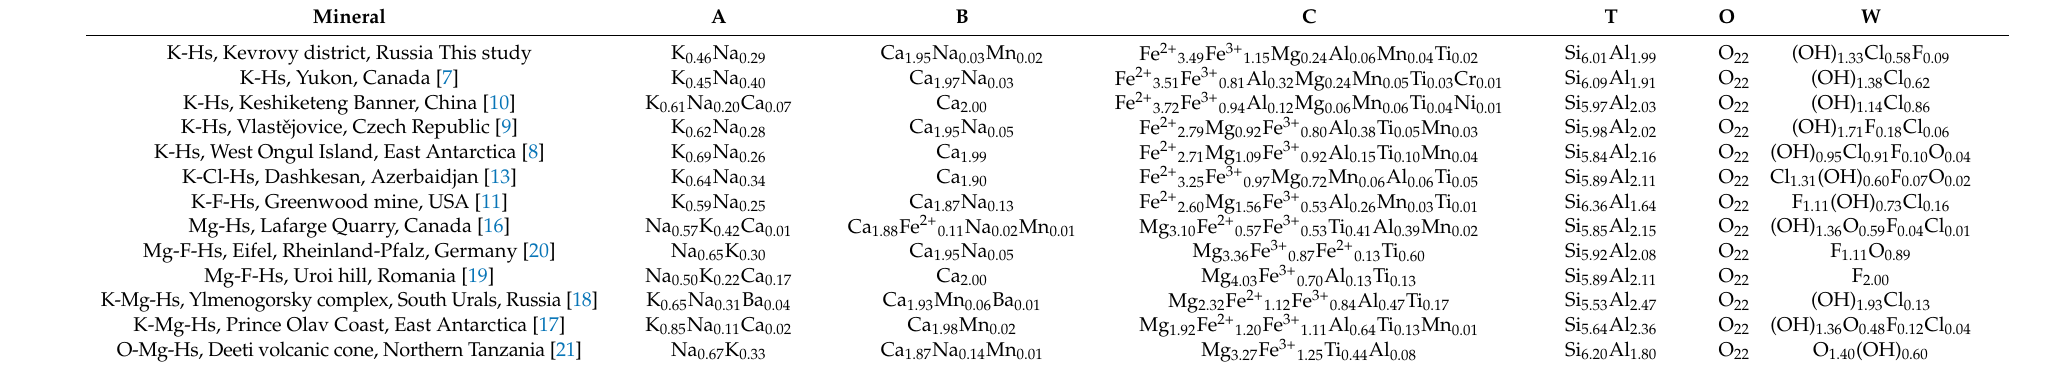
Table 5. Crystal chemical formulae and cation and anion distribution of the studied and literature hastingsite minerals, AB 2 C 5 T 8 O 22 W 2 . A —A site (pfu); B —2 × M4 site (pfu (per formula unit)); C —2 × M1, 2 × M2, 1 × M3 sites (pfu); T —4 × T1, 4 × T2 sites (pfu); W —2 × O3 sites (pfu). The abbreviations of hastingsite species used are the same as in Table 1. Mineral A B C T O